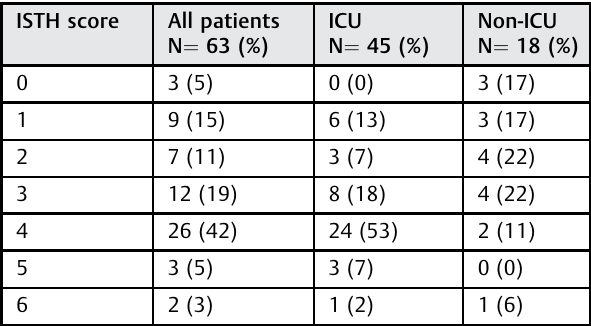
Table 2 ISTH score for compensated and non-compensated DIC in the whole group of patients, as well as in the cohort of ICU and non-ICU